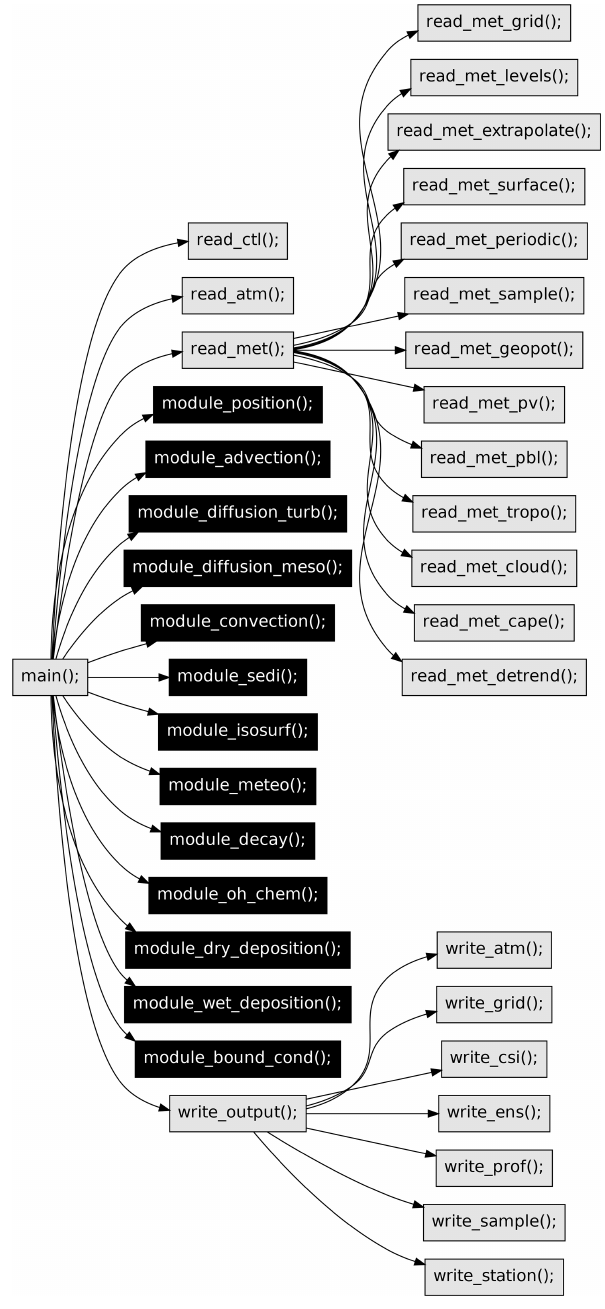
Figure 1. Call graph of the most relevant functions of the MPTRAC model. The individual functions are sorted following the IPO ap- proach; see text for details. Black boxes highlight parts of the code that are ported to